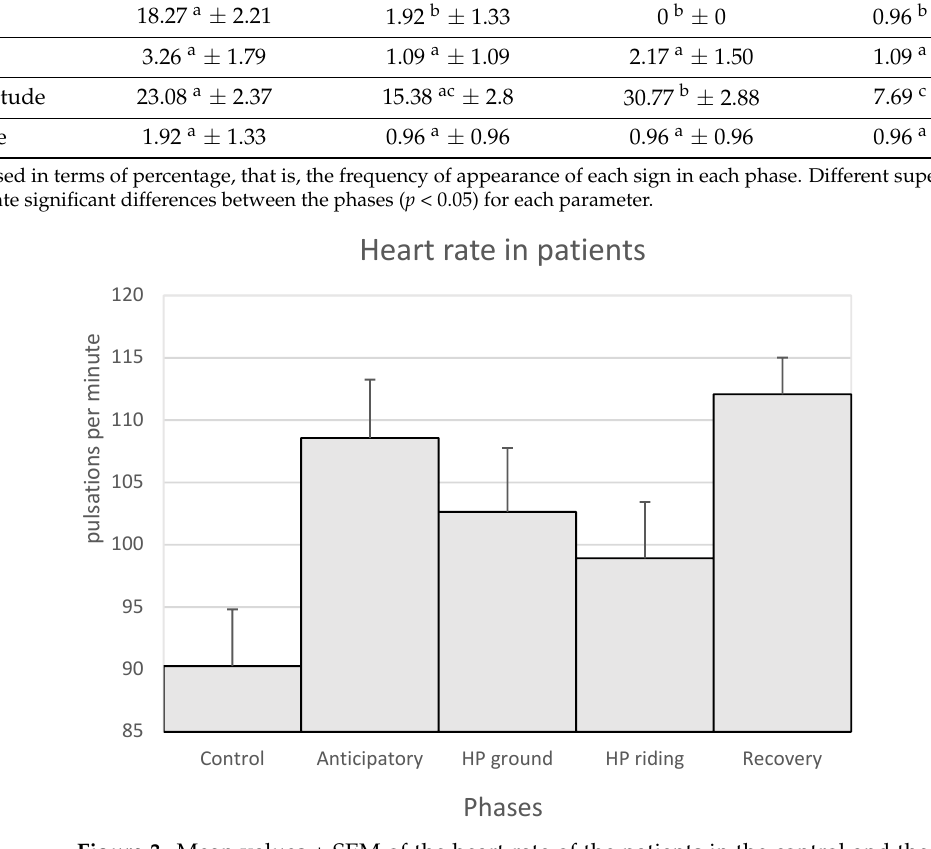
Figure 3. Mean values + SEM of the heart rate of the patients in the control and the anticipatory phases, the HP ground and HP riding phases (horse-patient interaction on the ground and on horseback, respectively) and the recovery phase. No significant differences were observed between the phases. Table 6. Mean values ± SEM of some physiological parameters the patients during the control and the anticipatory phases, the HP ground and HP riding phases (horse-patient interaction on the ground and on horseback, respectively) and the recovery phase. The sleeping phase refers to the time (expressed in minutes) of deep and light sleep on equine assisted therapy